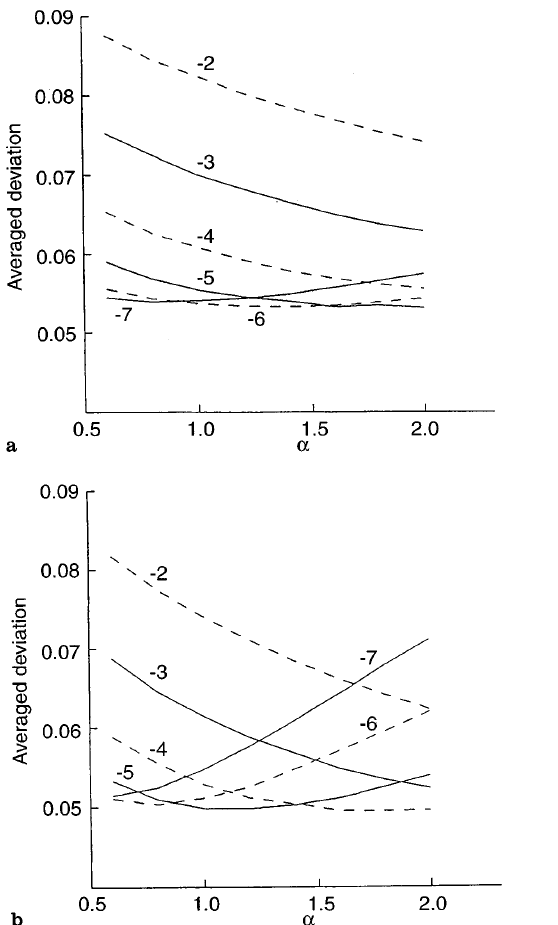
Fig. 3a,b. The comparison of calculated NO populations at an altitude 98km for (cid:107) 1 (cid:136) ) 7– ) 2 ( solid and dashed lines ) with the data of scan 137 of Rawlins et al . (1981) ( triangles ): a n (cid:136) 1, b n